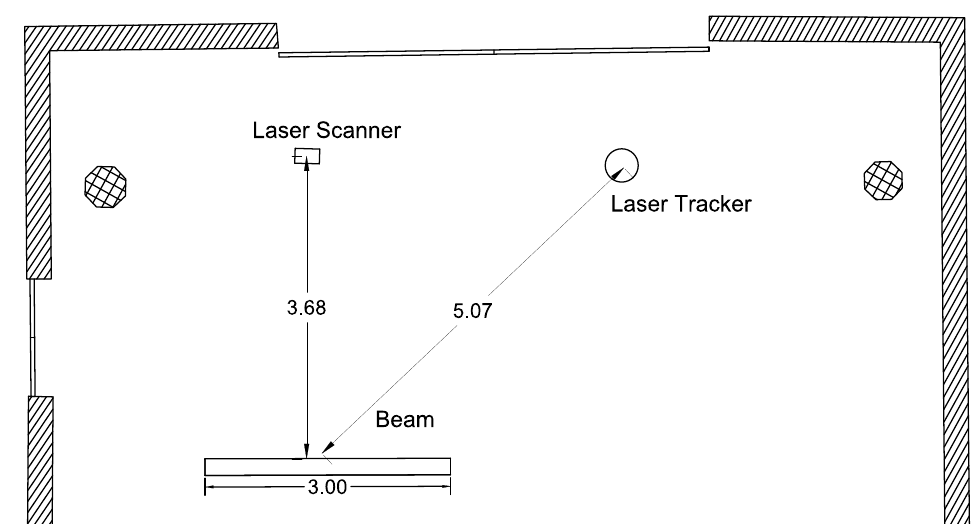
Figure 6. Plan view of the experimental instruments, distances are in meters.